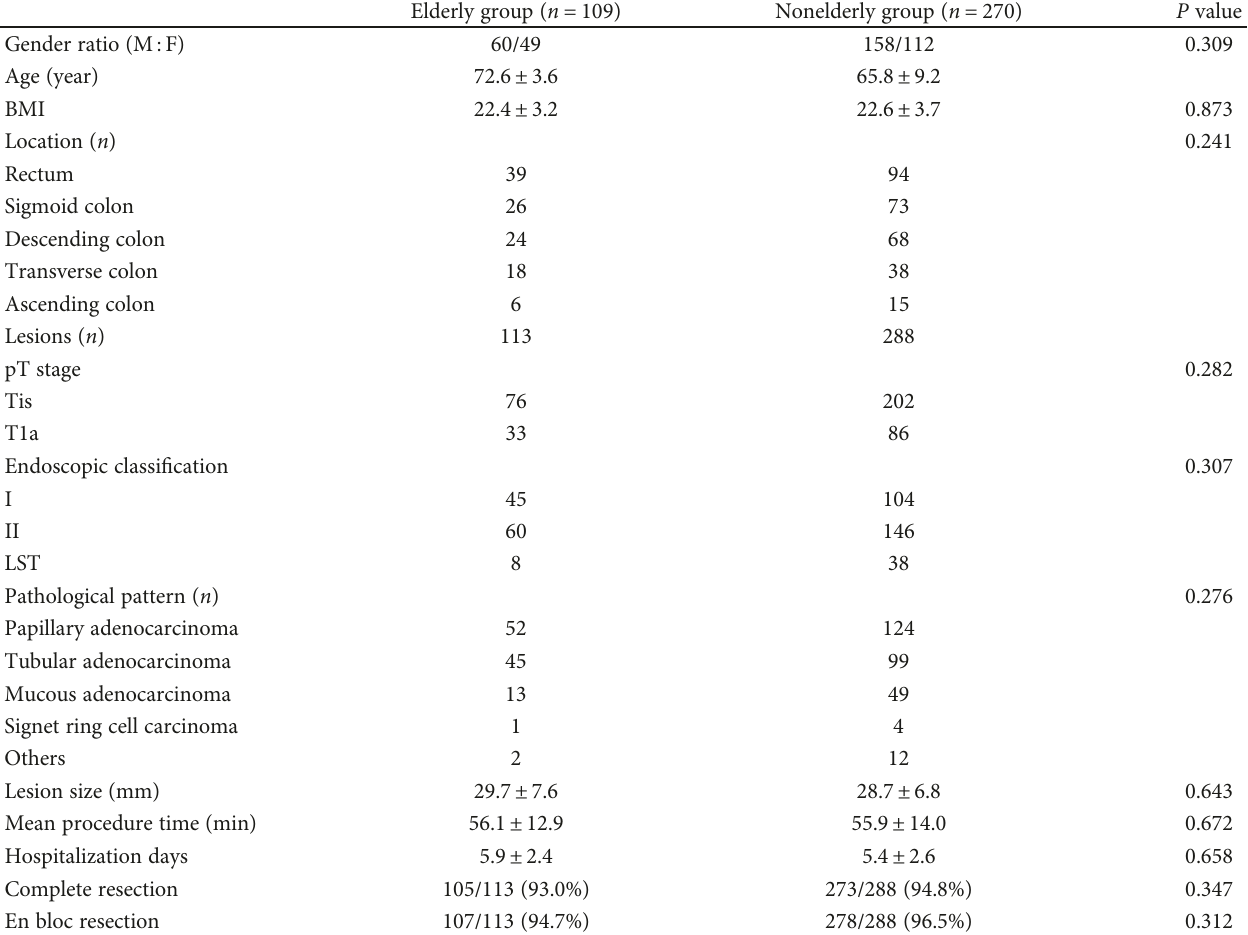
Table 1: Patients ’ baseline and clinicopathological characteristics in the elderly and nonelderly